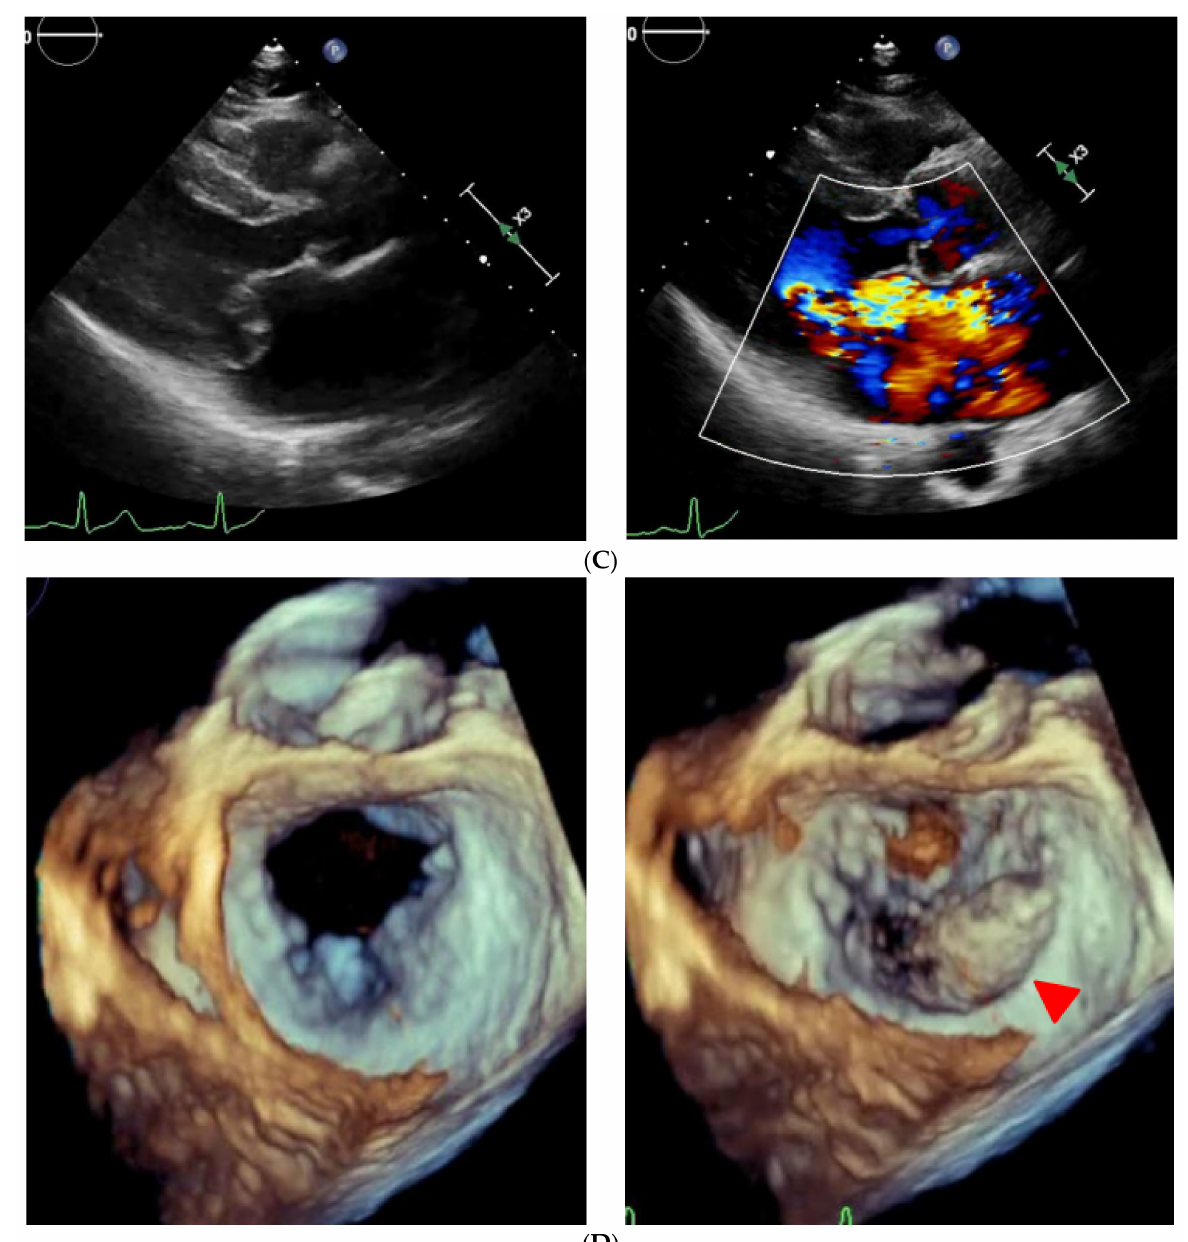
Figure 2. ( A ) Chest X-ray on admission showing slight cardiomegaly, pulmonary congestion, and the bilateral pleu- ral effusions. ( B ) Electrocardiography on admission showing normal sinus rhythm and left ventricular hypertrophy. ( C ) Transthoracic echocardiogram showing severe mitral regurgitation due to billowing with posterior mitral valve pro- lapse. ( D ) Transesophageal echocardiography showing the prolapsed P2 and P3 segment with the degenerated and thickened